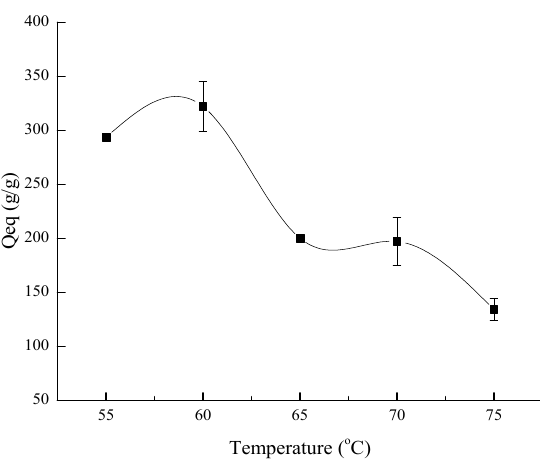
Figure 6. The influence of the reaction temperature on the water absorbency.